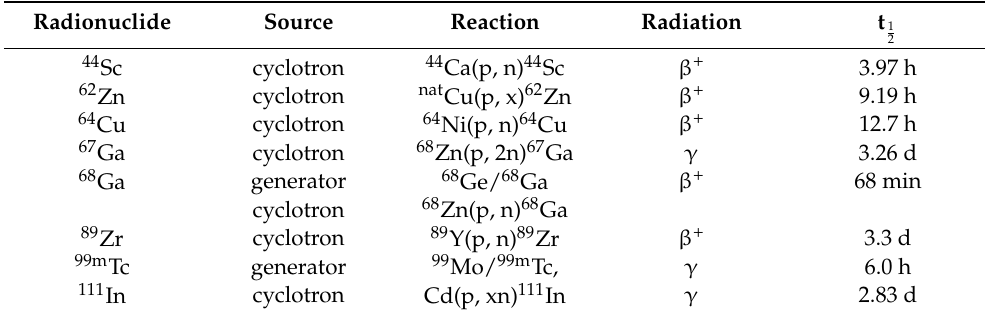
Table 1. The nuclear properties of the main radiometals used for PET and SPEC imaging. Table 1. T he nuclear properties of the main radiometals used for PET and SPEC imaging. Radionuclide